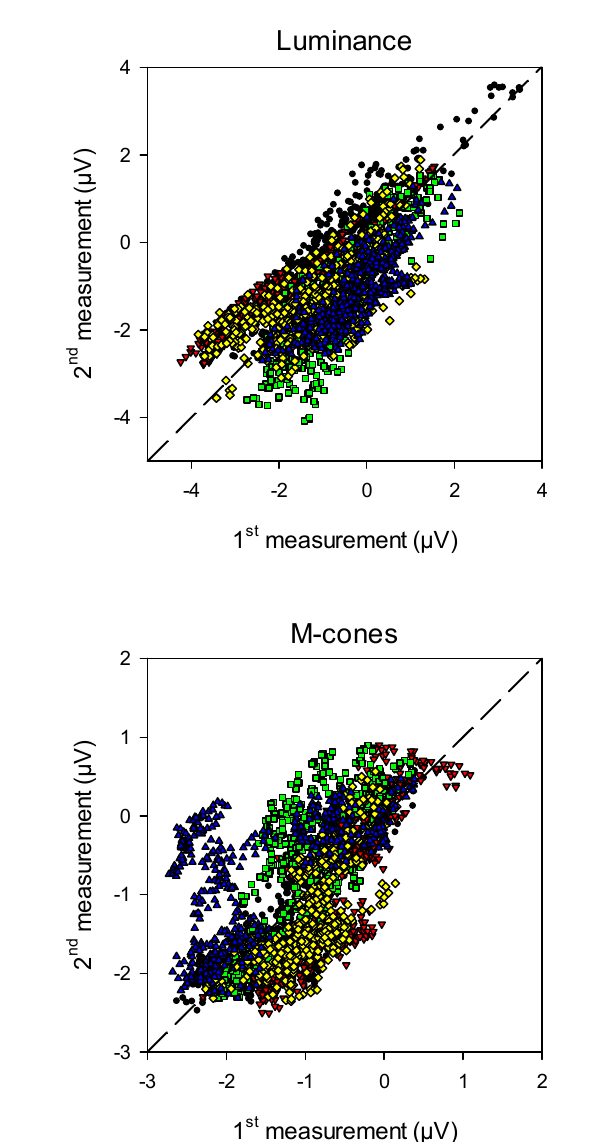
FIGURE6 Recorded wnERG potentials in the 2nd recordings vs. those in the 1st recording at equivalent times relative to the white noise stimulus for luminance, L-cone isolating and M-cone isolating conditions. The results are displayed for the five different animals.